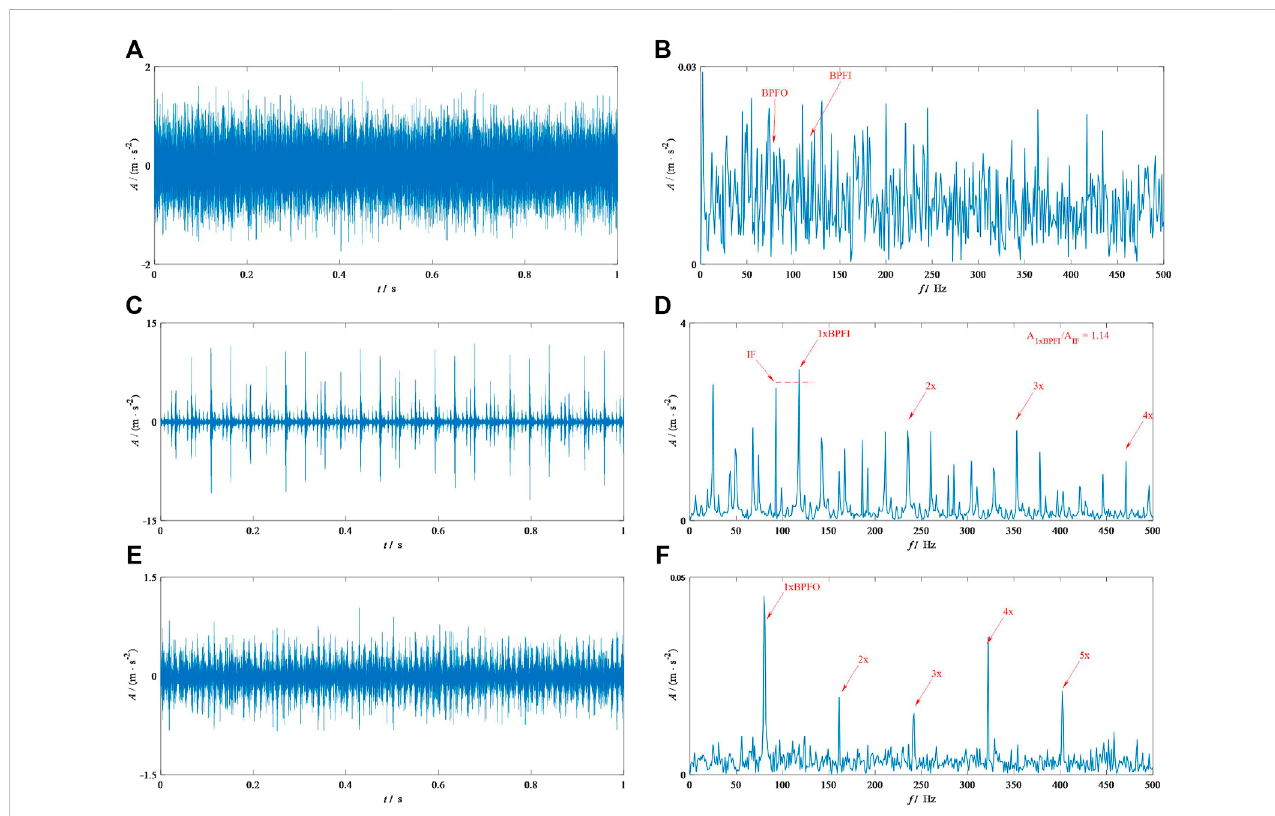
FIGURE 7 Final results of the IEFI – MVMD for signals from MFPT: (A) and (B) correspond to the TDW and SES of the healthy bearing, (C) and (D) correspond to the TDW and SES of the inner race fault bearing, and (E) and (F) correspond to the TDW and SES of the outer race fault bearing.